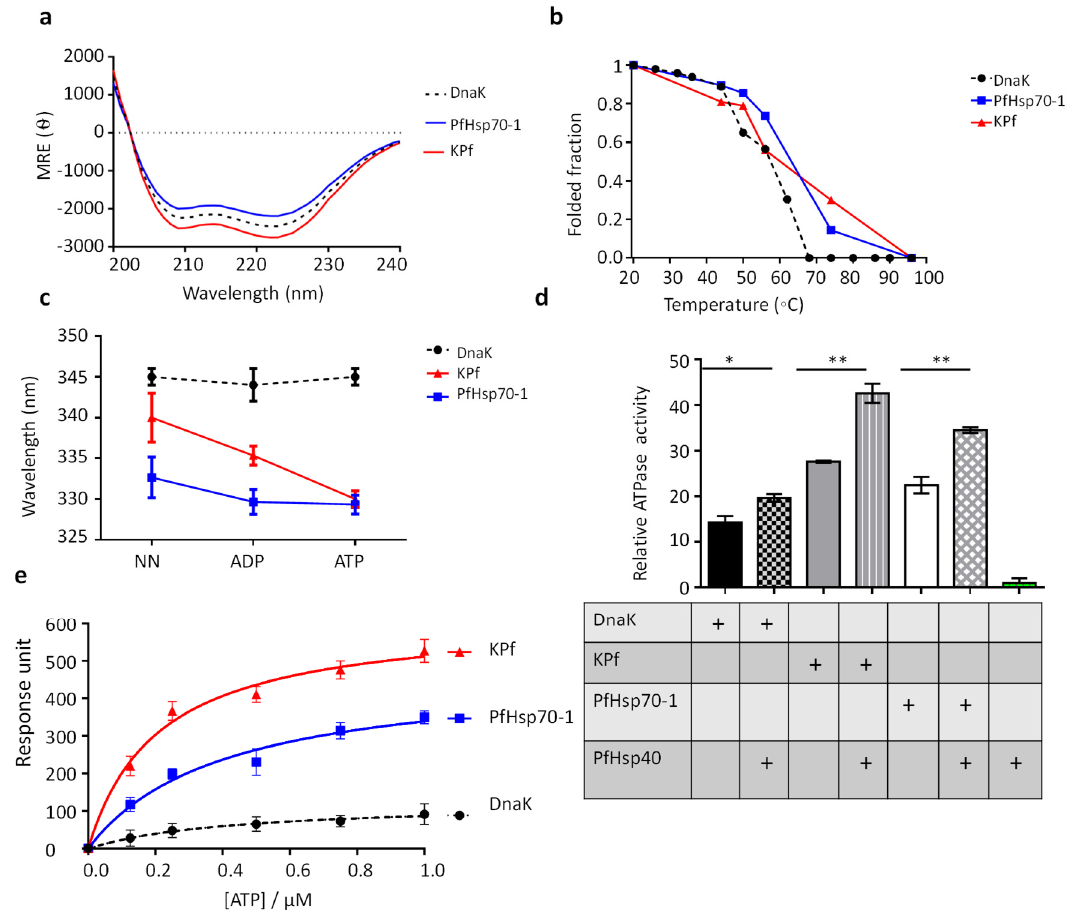
Figure 1. Comparative analysis of heat stability, nucleotide binding and hydrolysis kinetics of the Hsp70s. ( a ) Hsp70 far-UV spectra. The far-UV CD spectra of recombinant DnaK, KPf and PfHsp70-1 proteins were presented as molar residue ellipticity. All the three Hsp70s displayed a predominantly α -helical structure due to the negative troughs observed at 209 and 222 nm. ( b ) Comparative secondary structural fold of DnaK, PfHsp70-1 and KPf exposed to heat stress. The folded fraction of each protein was determined by comparing the spectral readings obtained at any given temperature with readings taken at 19 °C. ( c ) ATP dramatically modulates the conformation of KPf. Fluorescence emission spectra were monitored at 320–450 nm after an initial excitation at 295 nm. The tryptophan